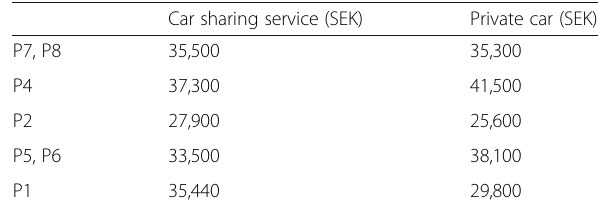
Table 4 Comparison of the approximate yearly cost of driving, using a car sharing service and the private car Car sharing service